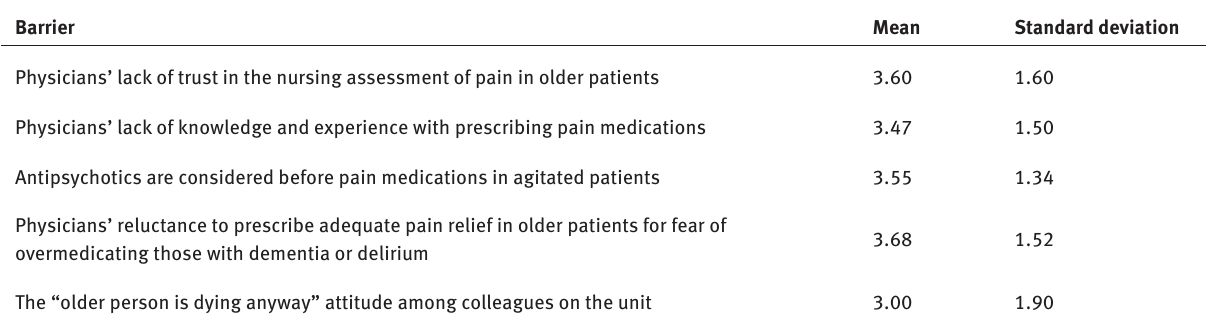
Table 3: Frequency characteristics of obstacles to optimal pain assessment and treatment in elderly patients associated with physicians.